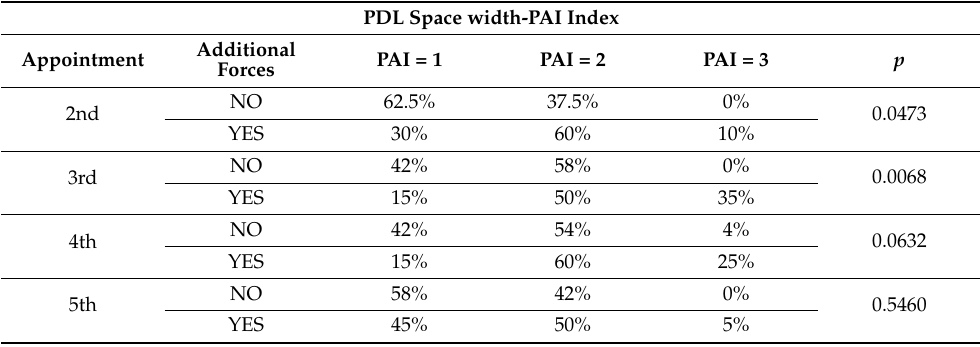
Table 11. Changes in periodontal ligament space width in endodontically treated